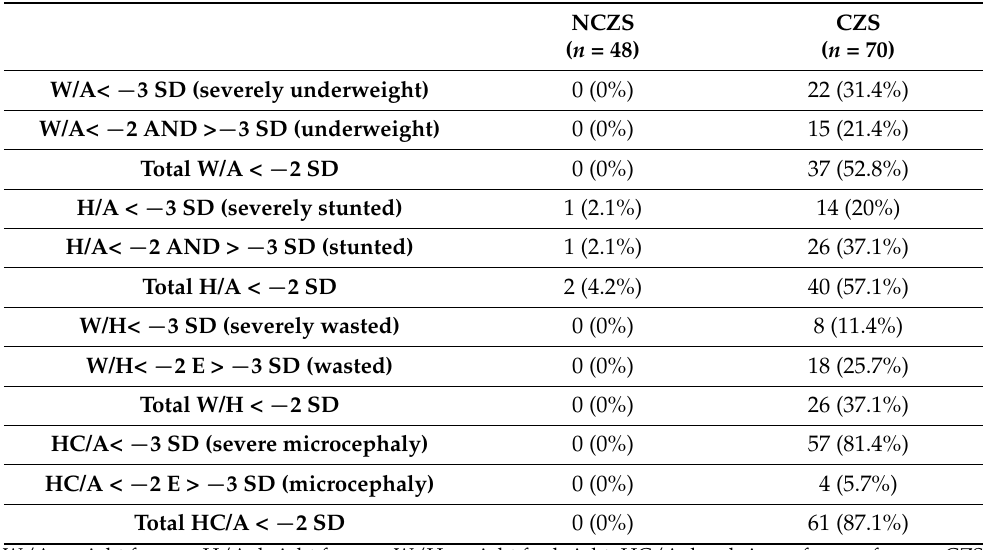
Figure 3. Head circumference, weight/height and BMI z-score means follow-up: CZS versus NCZS. Graphs compare ( A ) weight/height z-score for age, ( B ) body mass index/age z-score for age, ( C ) head circumference for age and ( D ) HC z-scores for age, based on the WHO Growth Standards. HC represents head circumference; W/H represents weight for height; BMI/A represents body mass index for age; CZS: congenital zika syndrome; NCZS: not congenital zika syndrome. Bars represent standard error. Table 2. Frequency of underweight status, stunting, wasting and microcephaly at 25–36 months in CZS versus NCZS